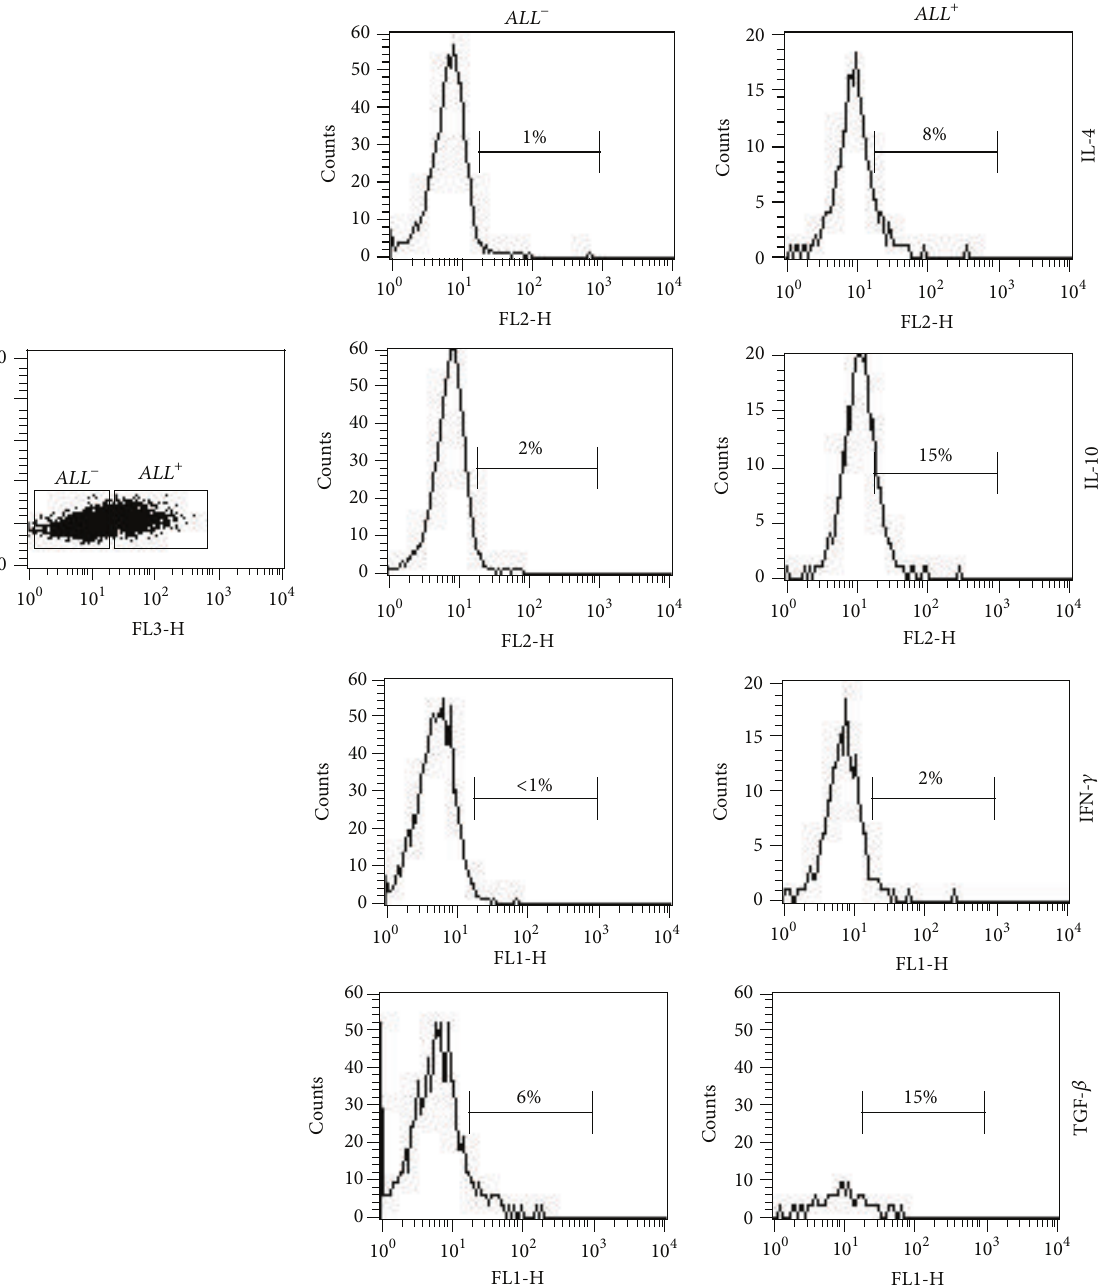
Figure 4: Frequency of intracellular cytokine positive cells on ALL − and ALL + gated cells. Freshly purified CD4 + T cells were incubated with ALL -Biotin followed by CyChrome-streptavidin incubation and stained with monoclonal antibodies against IL-4, IL-10, IFN- 𝛾 , or TGF- 𝛽 . Cells were analyzed by flow cytometry and gated on ALL − or ALL + cells. Percentages of cells positive to intracellular cytokines are shown in